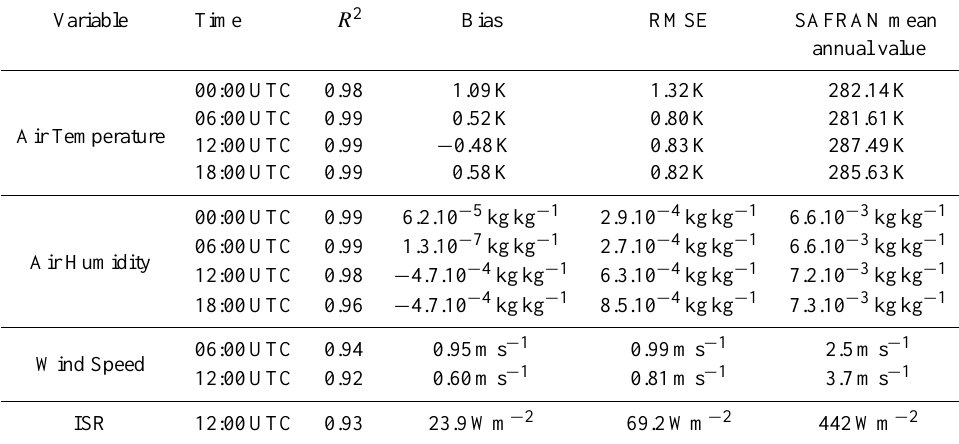
Table 5. Average T a , q a , wind speed and ISR for the whole France domain: ERA-I vs. SAFRAN (mean bias (ERA-I minus SAFRAN), RMSE and R 2 ) , based on daily values over the 1991–2008 period, for T a and q a at 00:00, 06:00, 12:00 and 18:00UTC, for wind speed at 06:00 and 12:00UTC, and for ISR at 12:00UTC, over France. Variable Time R 2 Bias RMSE SAFRAN mean annual value 00:00UTC 0.98 1.09K 1.32K 282.14K 06:00UTC 0.99 0.52K 0.80K Air Temperature 12:00UTC